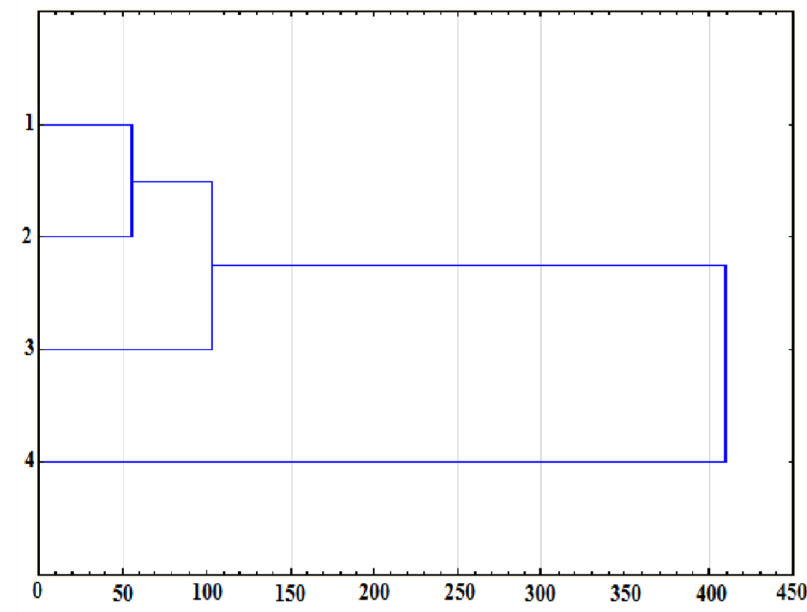
Table 3. Correlations of flexibility tests with sport skill levels for 7b–8c RP climbers.